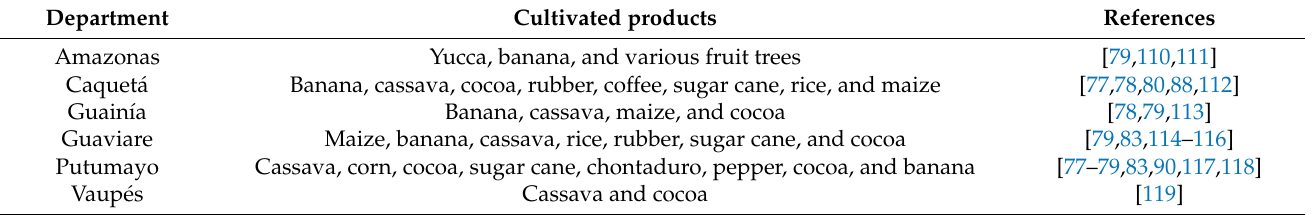
Table 10. Amazon region.